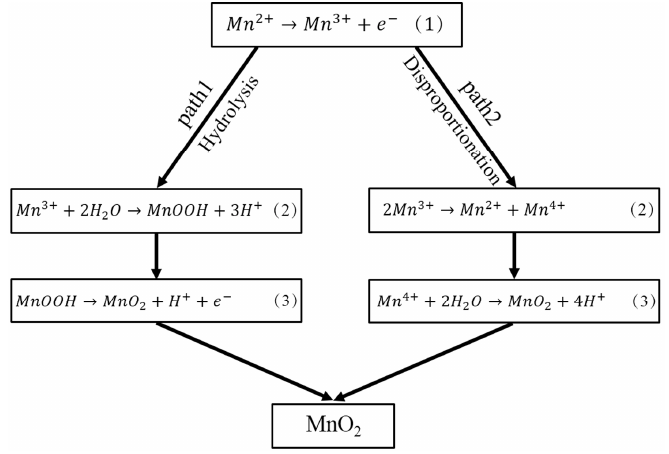
Figure 2. Two synthesis paths of MnO 2 in the MnSO 4 electrolyte.